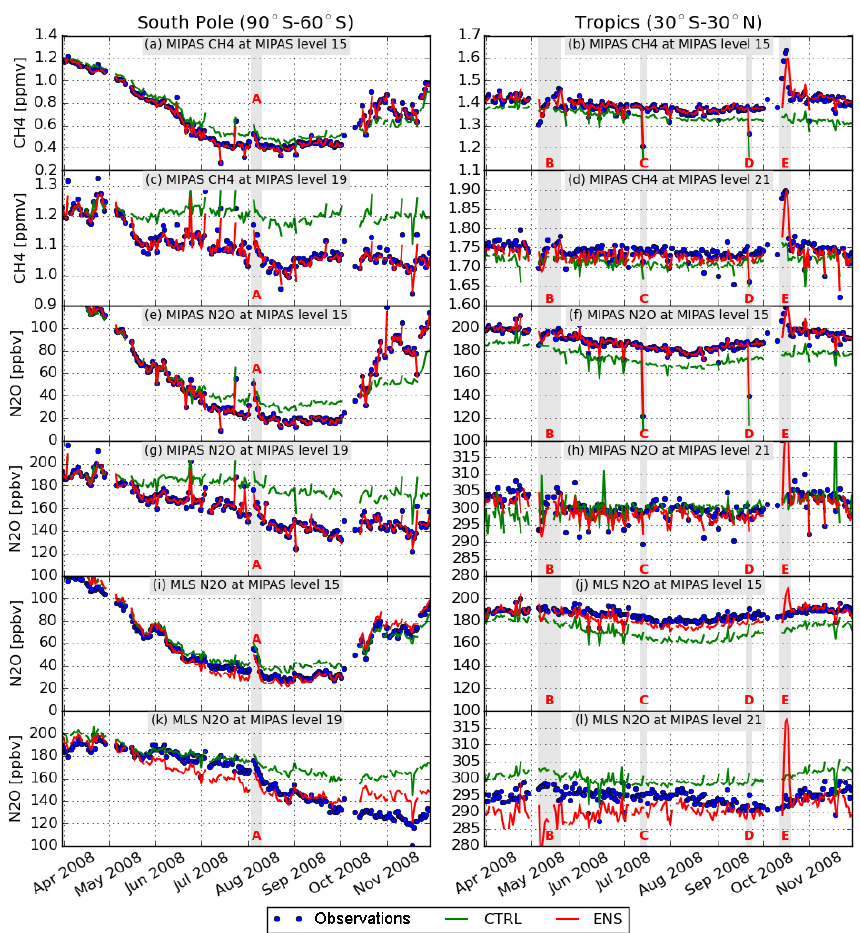
Figure 9. Time series between April and November 2008 for CH 4 and N 2 O daily averaged in two latitude bands: between 90–60 ◦ S (left, southern polar region) and between 30 ◦ S–30 ◦ N (right, tropics). Above the southern polar region, values are shown at MIPAS levels 15 and 19 which correspond approximately to 20 and 65hPa. In the tropics, values are shown at MIPAS levels 15 and 21, around 15 and 70hPa. Plots (a–d) , (e–h) and (i–l) show MIPAS CH 4 , MIPAS N 2 O and MLS N 2 O (blue dots) and the corresponding values for ENS (red line) and CTRL (green line). In the case of MLS (plots i–l ) , observations and BASCOE values are interpolated from the MLS pressure grid to the MIPAS daily average pressure. Shaded periods A, B, C, D and E are discussed in the